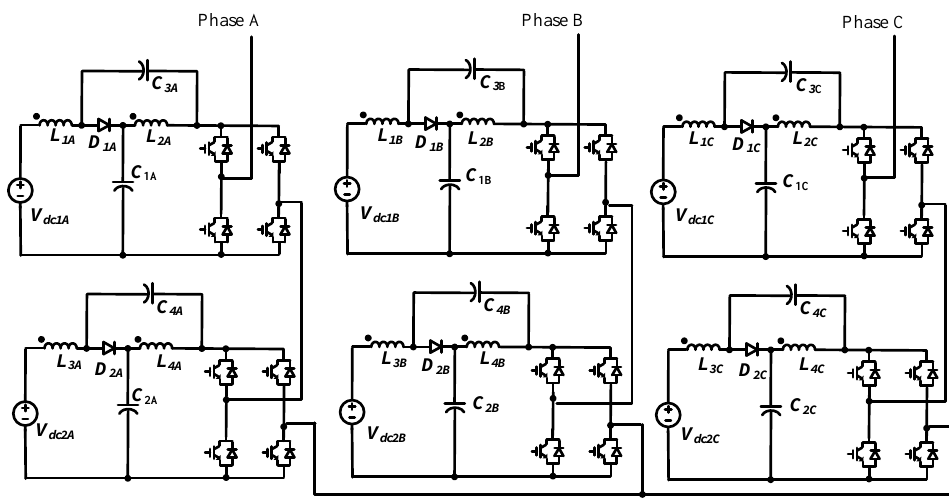
Figure 2. Construction of three-phase CHB quasi-Z-source inverters (CHB-qZSI) topology.